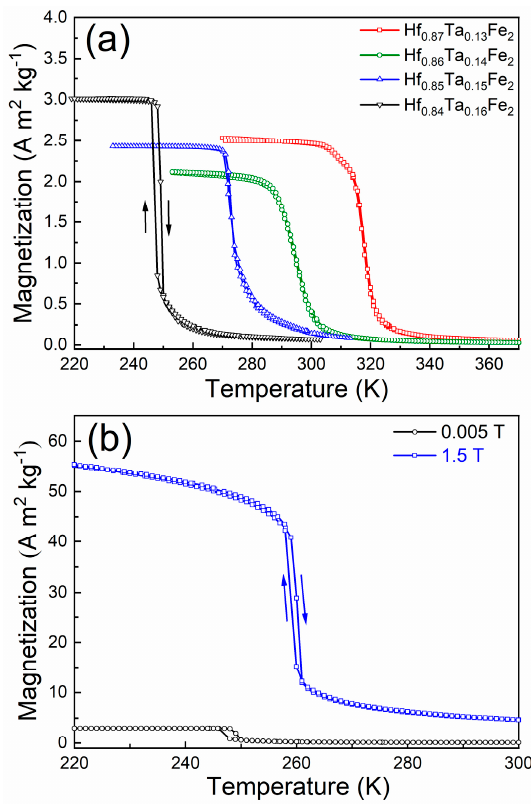
Figure 2. ( a ) Temperature dependence of magnetization ( M ( T ) curves) under the field of 0.005 T for the Hf 1 − x Ta x Fe 2 ( x = 0.13, 0.14, 0.15, 0.16) alloys. ( b ) Comparison on the M ( T ) curves under 0.005 T and 1.5 T for the Hf 0.84 Ta 0.16 Fe 2 alloy.